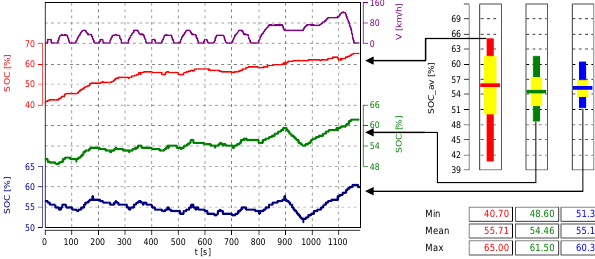
Fig. 5. Initial and average SOC values for various degrees of initial battery discharge and charging conditions during the NEDC test [14]